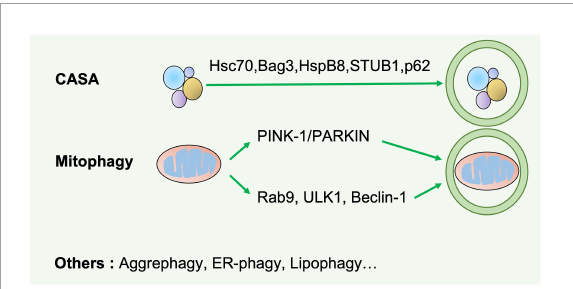
FIGURE2 Selective autophagy. Selective autophagy delivers specific cargos for degradation and recycling, such as protein aggregates, mitochondria, and endoplasmic reticulum. The recognition of these cargoes requires selective autophagy receptors specifically binding LC3-II of autophagosomes and are thereby removed by lysosomes. CASA is a selective tension-induced autophagy pathway mediated by BAG3. Moreover, mitophagy is divided into two branches: the classical PINK1/PRAK2-mediated process and alternative mitophagy